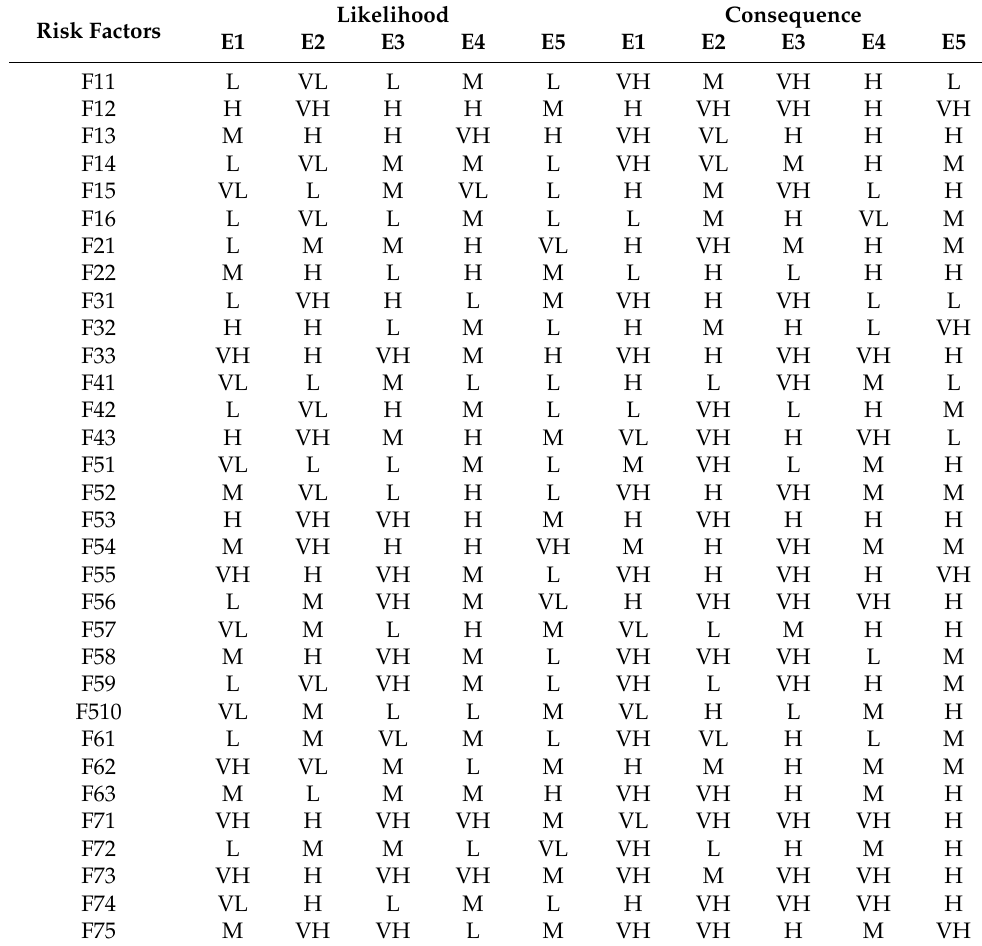
Table 3. Linguistic judgements for the likelihood and consequence of risk